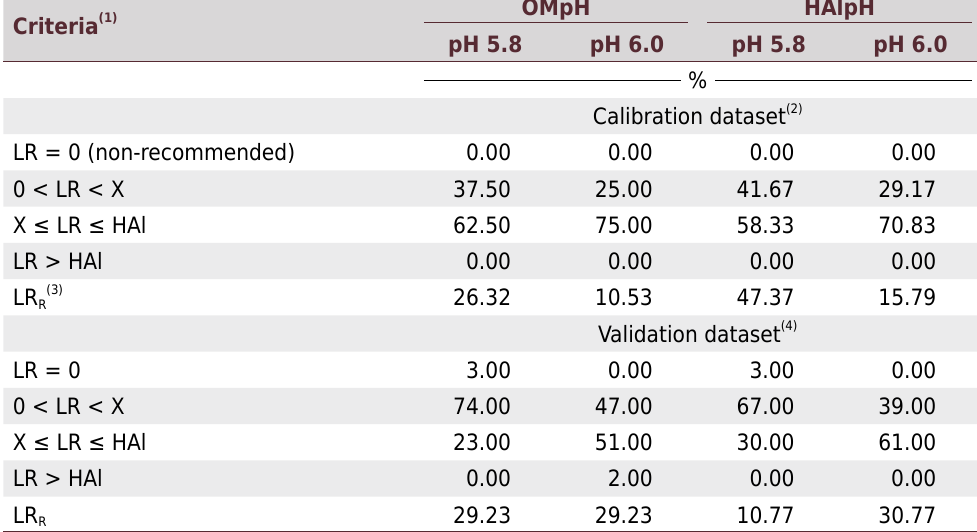
Table 6. Recommendation frequency of lime requirement (LR) estimated by the new predictive models according to the algorithm criteria for the soils used to develop and validate the new predictive